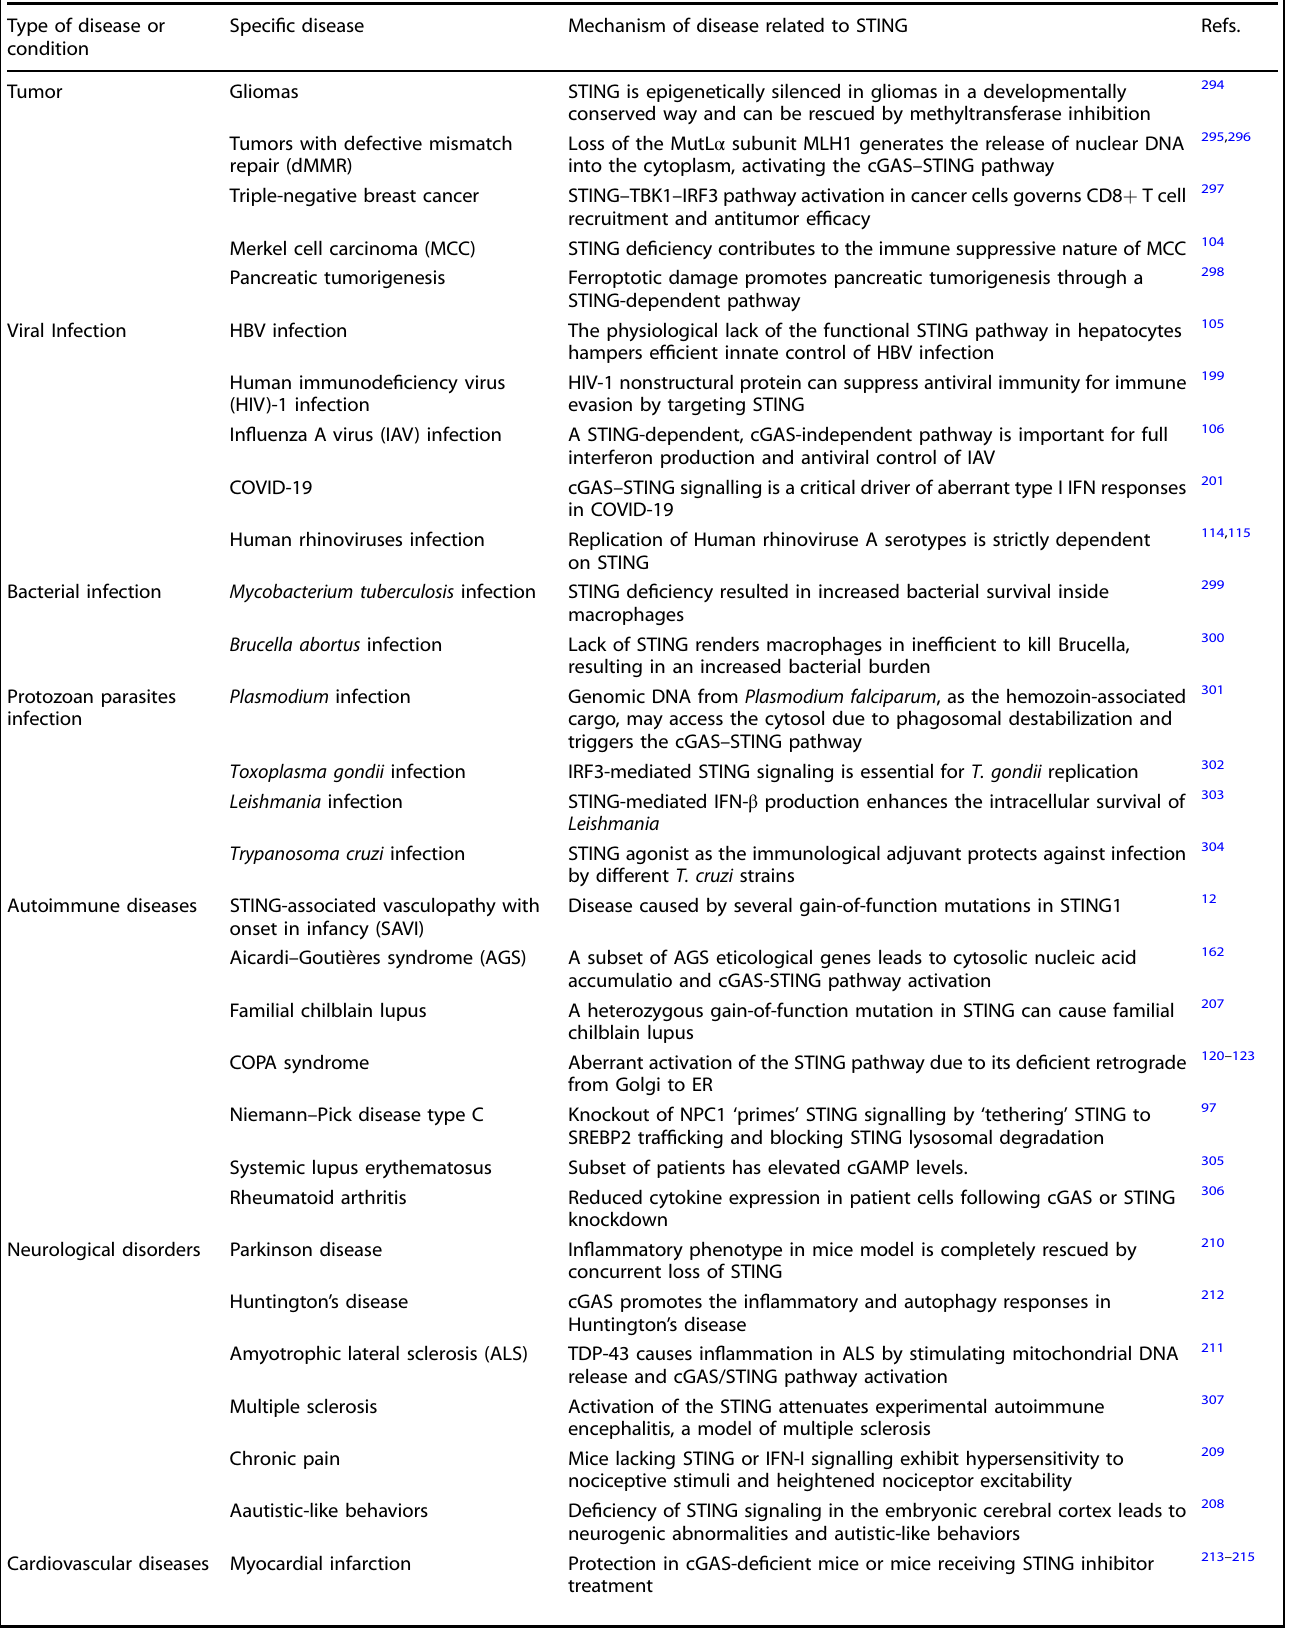
Table 3. STING-associated diseases Type of disease or